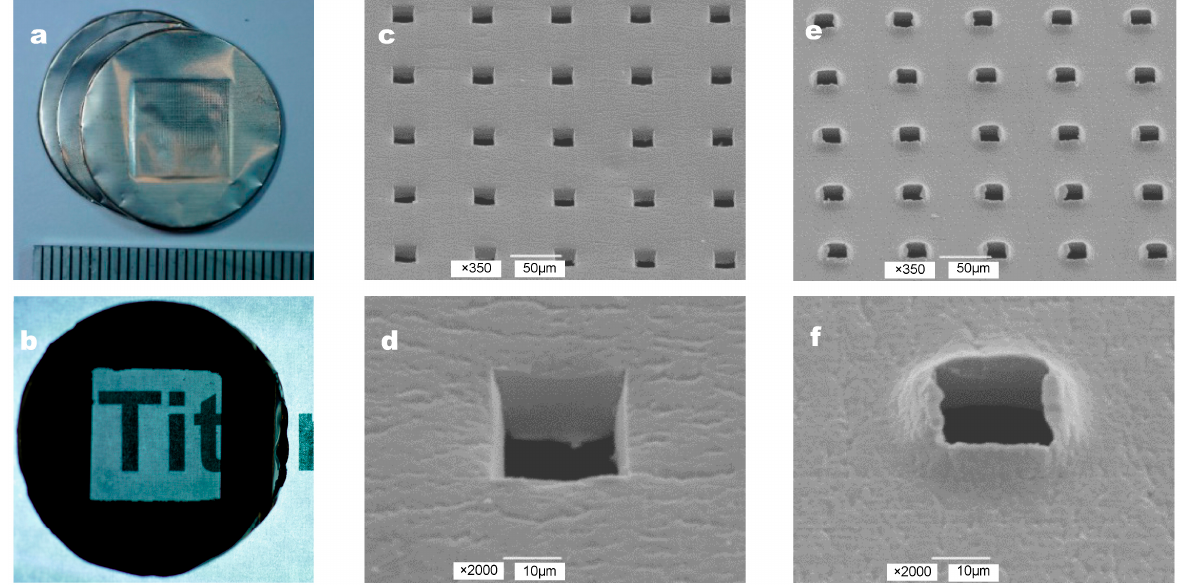
Figure 3. The form of the Ti membrane: ( a ) Approximately 17,700 microneedles in a 10 mm square block pierced the disc with a diameter of 22 mm to form hole arrays. ( b ) The partial transparency was preserved in the microperforated area, and an image was captured through the membrane. ( c ) The surface structures of microperforated arrays in Ti membranes using scanning electron microscopy. An overview of the 25 µ m × 25 µ m square aperture on the head side (the scale bar represents 50 µ m). ( d ) A higher magnification view of an aperture on the head side (the scale bar represents 10 µ m). ( e , f ) Two different magnification views of the tail side (the scale bars represent 10 or 50 µ m).